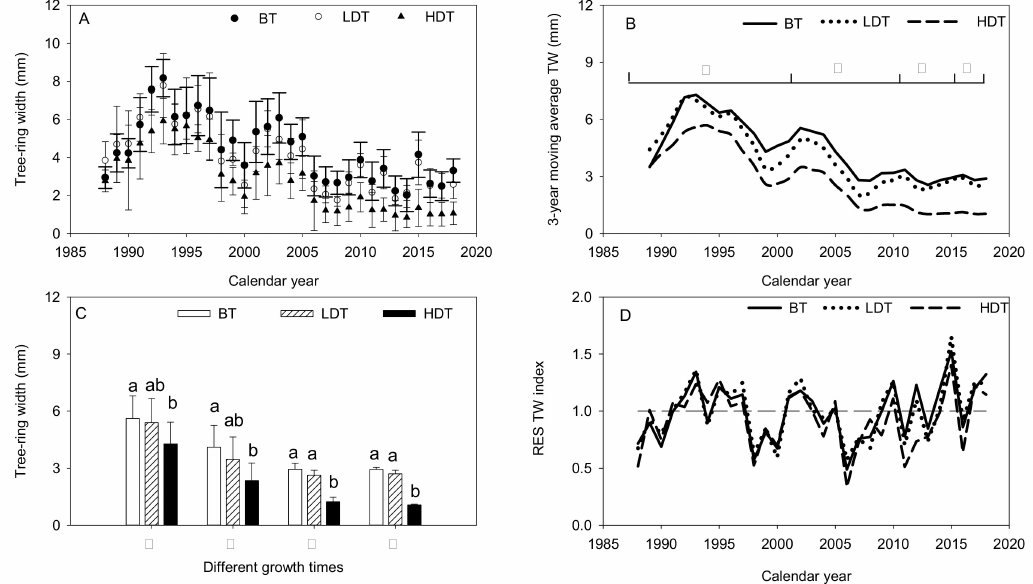
Figure 3. Di ff erences in tree-ring width ( A ) and 3-year moving average tree-ring width ( B ) among three densities of Mongolian pine trees. Di ff erence in tree-ring widths among the three density groups in di ff erent growth periods ( C ). Lower-case letters indicate significant di ff erences at p < 0.05. Residual tree-ring index among the three densities of the stands ( D